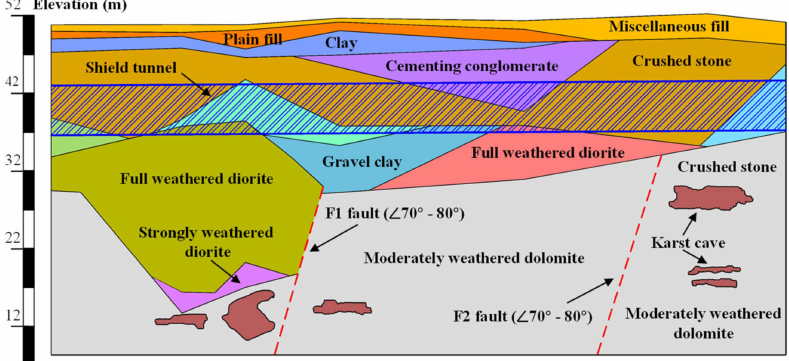
Figure 1. Engineering geologic profile of the shield tunnel crossing the fault zone.